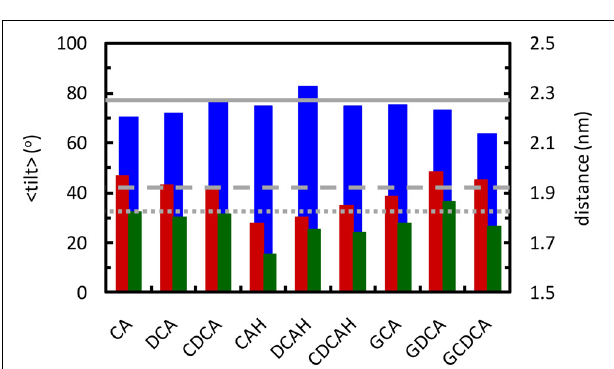
FIGURE 9 | Average tilt angle of the lipid P-N vector (blue, left ordinate axis), and average position of N and P atoms (red and green, respectively; right ordinate axis), for the lipids that are within 0.6 nm from the BS molecules. Solid, dashed and dotted gray lines show the average tilt angle and the position of N and P atoms in the pure POPC bilayer,